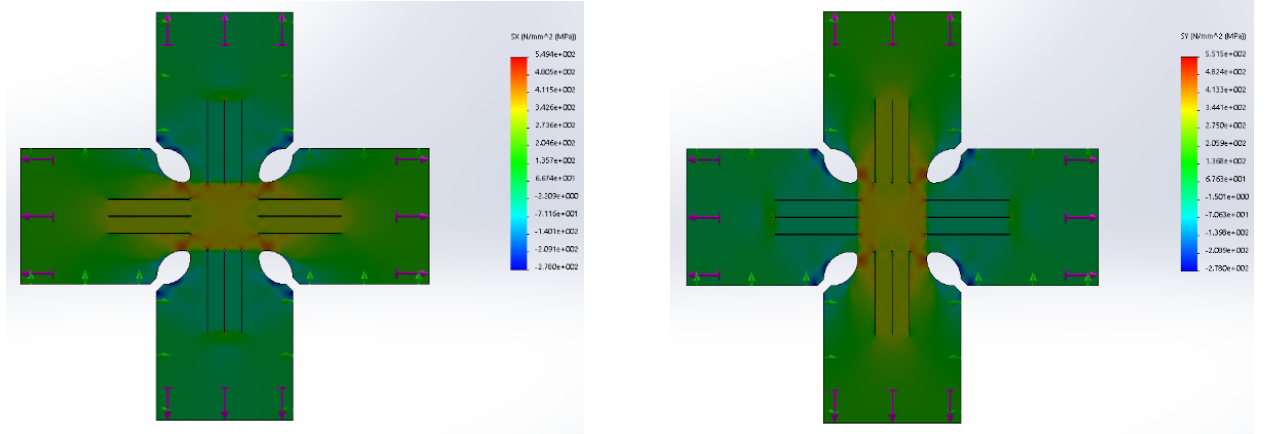
Figure 28. On the left, stress distributions SX on the x-axis are equal to σ x , and on the right, stress distributions SY on the y-axis are equal to σ y using von Mises condition. Purple arrows show the direction of the load; green arrows show the virtual action of the slider.